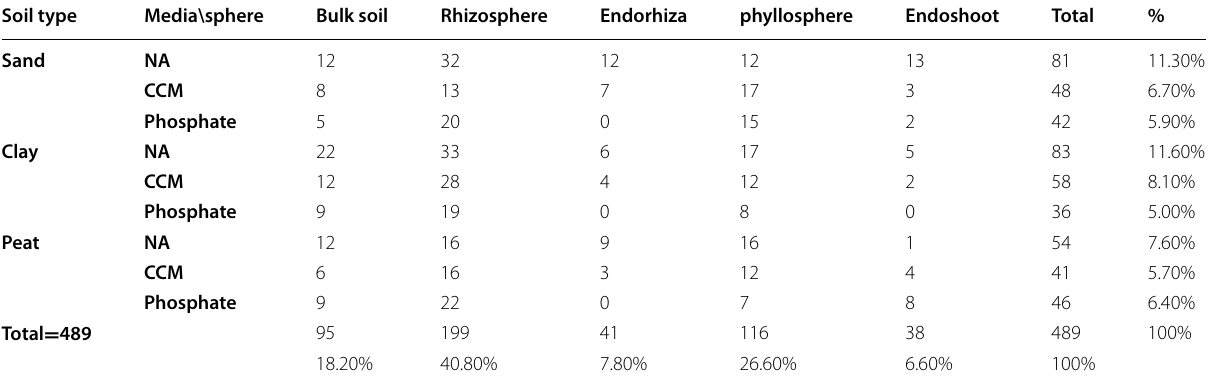
Table 3 Total number of isolates obtained from different spheres and soil types using different isolation media Soil